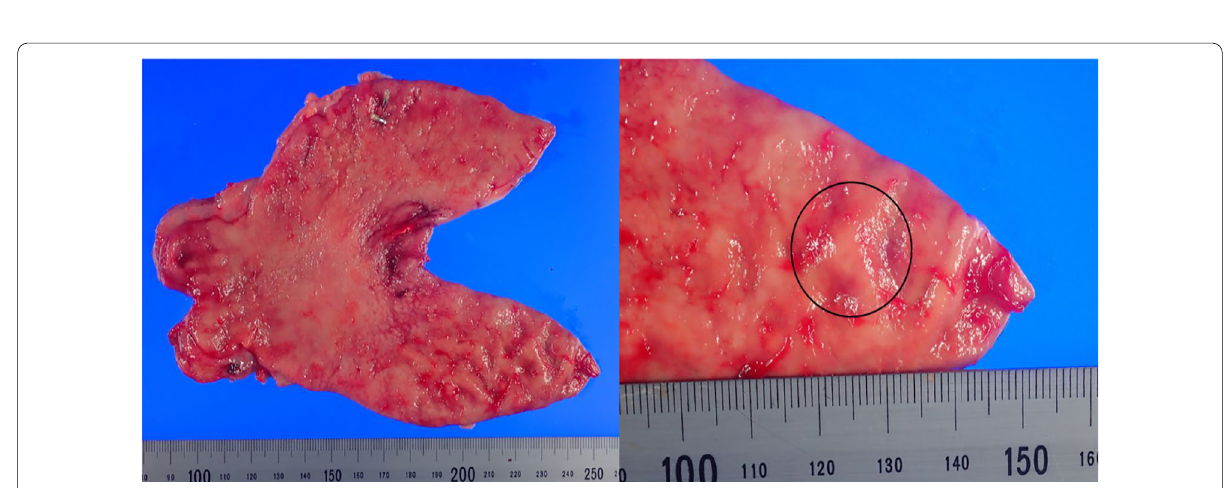
Fig. 2 The resected specimen showed an SMT 7